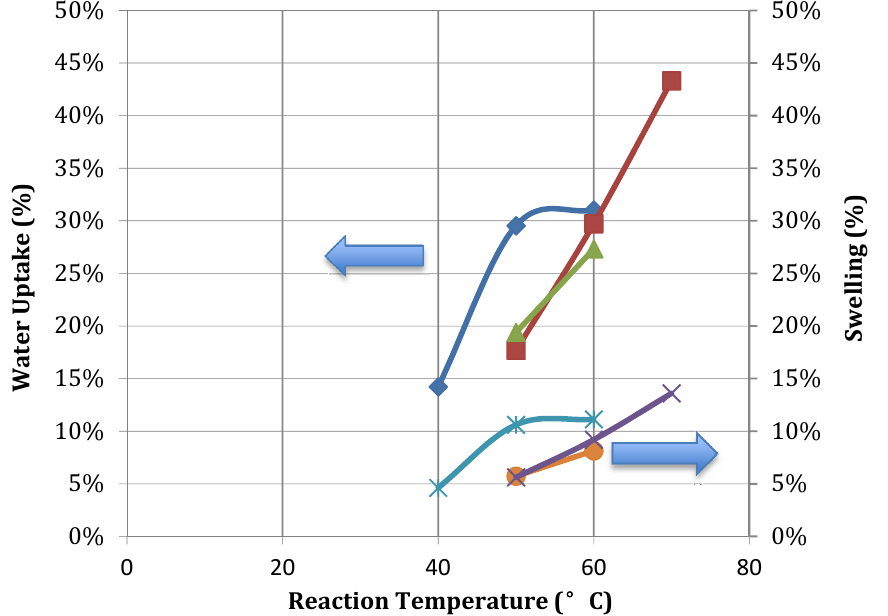
Figure 4. SPEEK membrane water uptake and swelling according to reaction temperature (×, 6 h swelling; ○ , 3 h swelling; *, 2 h swelling; diamond, 6 h WU; ∆ , 3 h WU; □ , 2 h